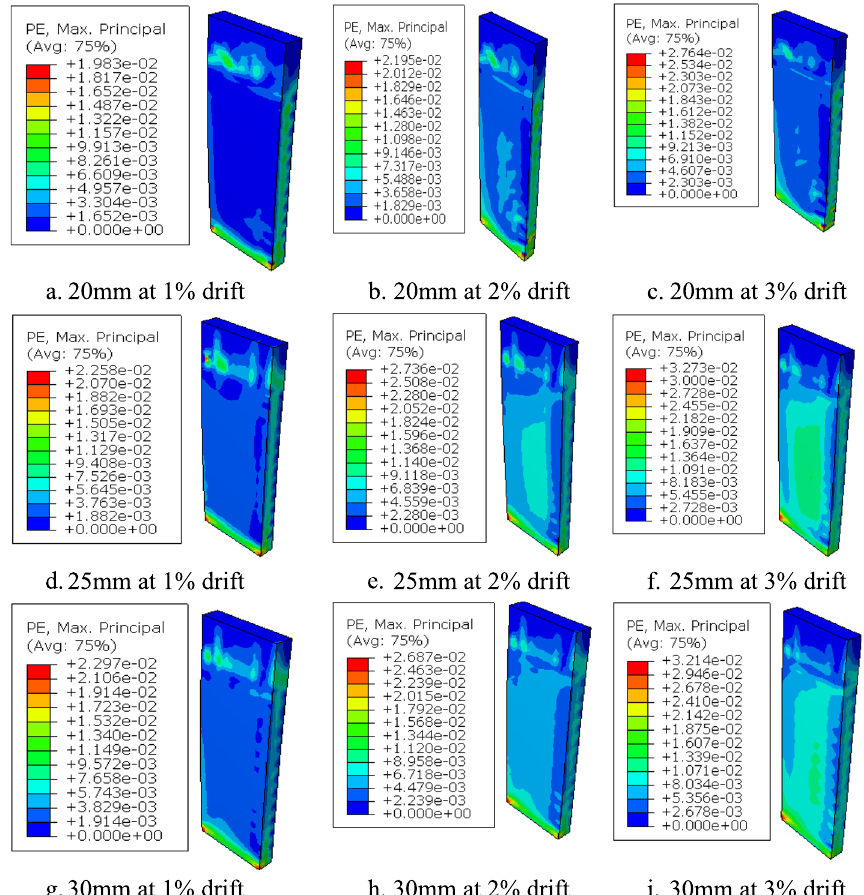
of fire, and fire exposure sides and comparison was made between steel and GFRP bars being used as reinforcement on the seismic performance of fire exposed shear walls. The following conclusions were drawn based on the simulation results of this